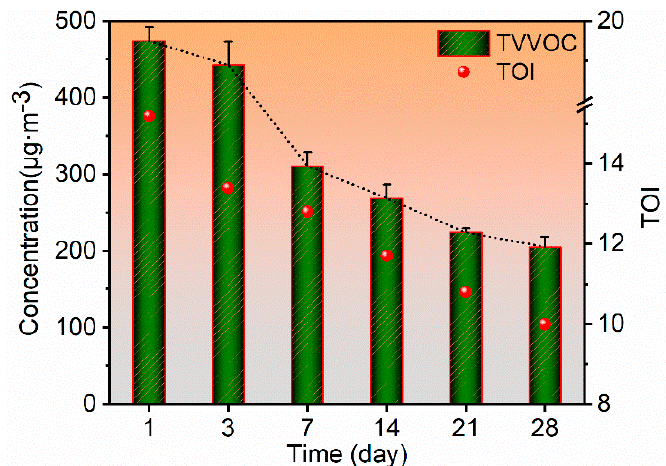
Figure 1. TVVOC and TOI of WB-MDF.